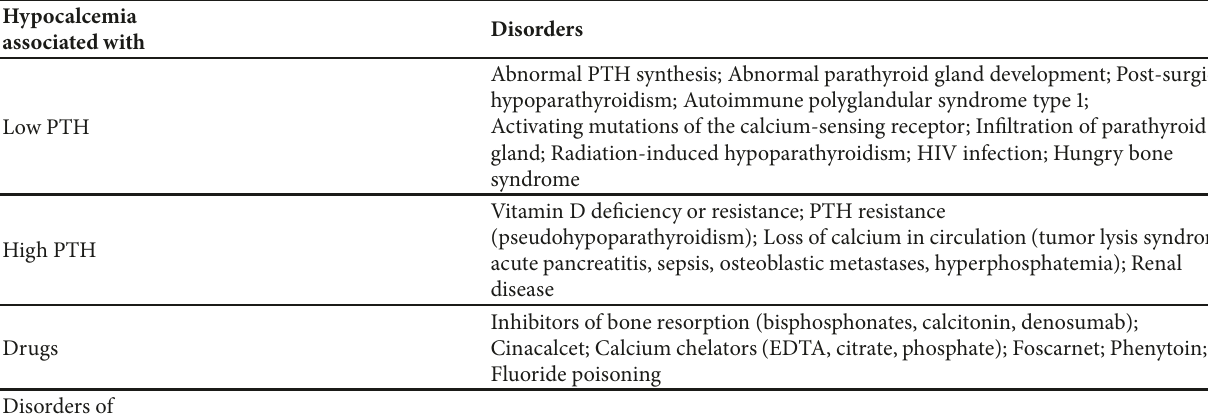
Table 2: Pathogenesis and differential diagnosis of